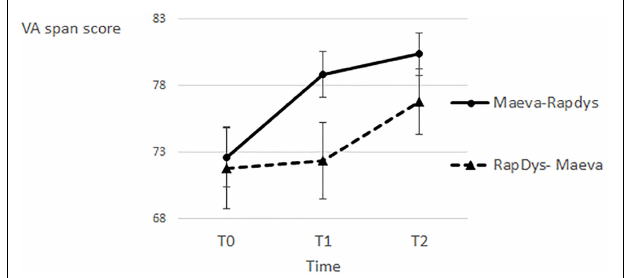
FIGURE 4 | Visual attention span scores for each time period and each presentation